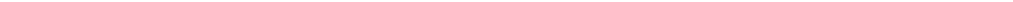
Fig. 4 SCAT1 and SCAT5 act as oncogenic drivers and prognostic markers for lung-derived and kidney-derived cancers, respectively. a Bar graph showing the signi fi cant differential expression levels of SCAT1 expressed as log 2 fold change across 10 different cancer types obtained from TCGA data sets. b Kaplan – Meier plots of SCAT1 indicating overall survival of patients in LUAD (upper left panel) and LUSC (lower left panel) cancer types. The higher expression of the SCAT1 is correlated with poor overall survival. The upper and lower right panels represent the multivariate models of LUAD and LUSC cancers, respectively, derived from Cox proportional hazard analysis and associated p -values were calculated using Wald statistics. c MTT proliferation assay of A549 (LUAD) cell line depleted with two different LNA oligos targeting SCAT1 . d Cell cycle pro fi les of control and SCAT1 KD A549 cells. e Estimation of caspase 3/7 activity in control and SCAT1 KD A549 cells. f Bar graph showing the signi fi cant differential expression levels of SCAT5 expressed as log 2 fold change across fi ve different cancer types obtained from TCGA data sets. g Kaplan – Meier plots of SCAT5 indicating overall survival of patients in KICH (upper left panel) and KIRP (lower left panel) kidney cancer. The higher expression of the SCAT5 is correlated with poor overall survival. The upper and lower right panels represent the multivariate models of KICH and KIRP cancers, respectively. h MTT proliferation assay of Caki-2 cell line 48 h post- silencing of SCAT5 using two different LNAs. i Cell cycle pro fi les of control and SCAT5 KD Caki-2 cells. j Estimation of caspase 3/7 activity in Caki-2 cells 48 h post-silencing of SCAT5 . The signi fi cance in fi gures a and f was derived using Benjamini – Hochberg ’ s method. Note that the data presented in c – e and h – j represents the mean values of three independent experiments and statistical signi fi cance was derived using a two-tailed unpaired Student ’ s t -test. Data are plotted as mean ± SD (* p ≤ 0.05; ** p = 0.01 ̶ 0.001; *** p <